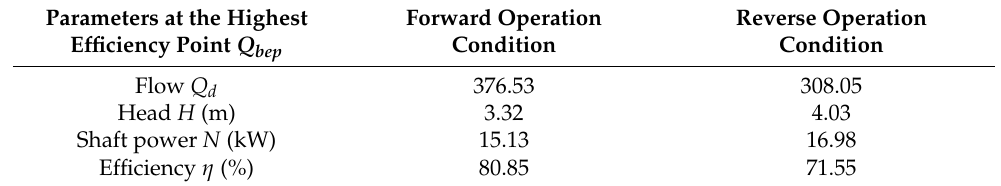
Figure 7. Experimental energy characteristic curve of bidirectional axial flow pump. Table 3. Characteristic parameters of highest efficiency points for forward and reverse operation.